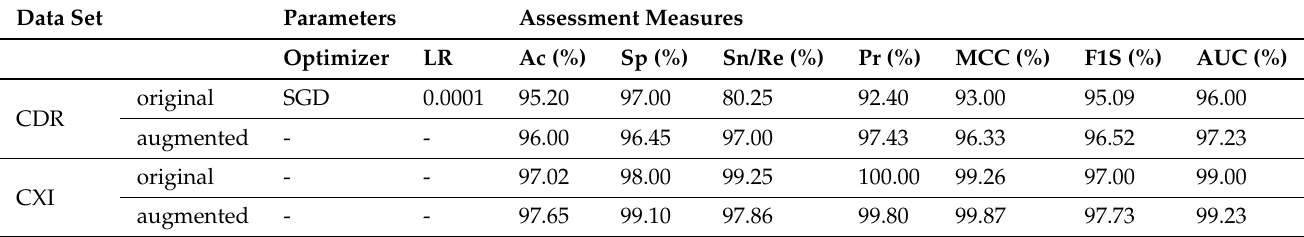
Table 3. 2DCNN model performance evaluation on original and augmented CRD and CXI data